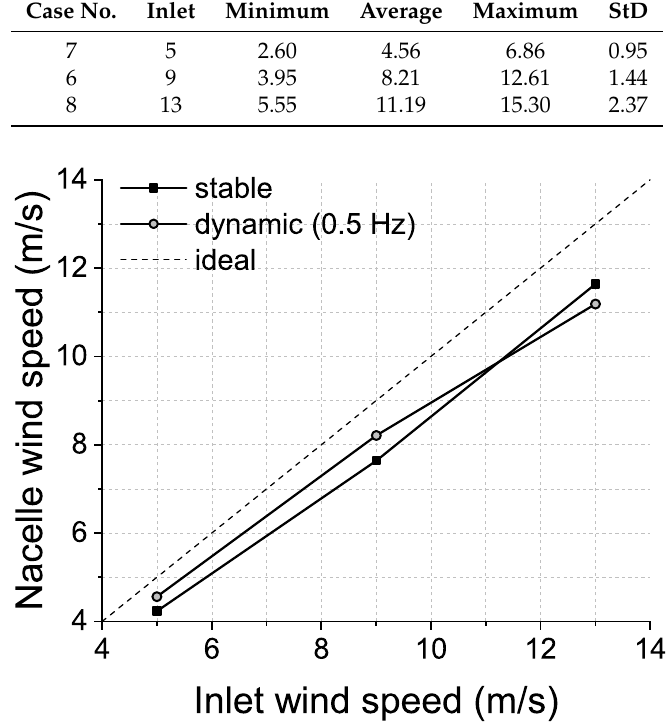
Figure 11. NTF curves with stable or dynamic inlet